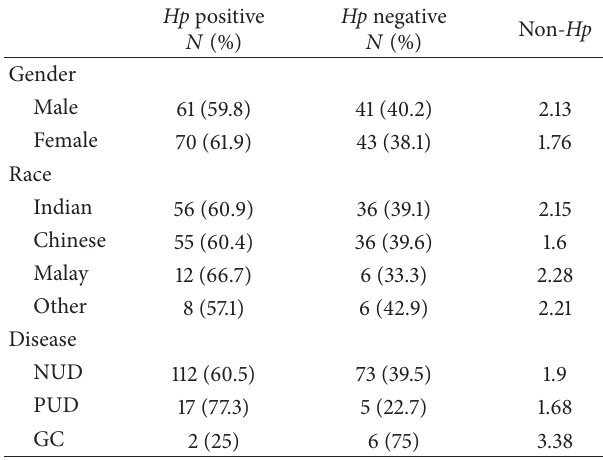
Table 1: Demographic data, prevalence of Helicobacter pylori , and mean number of other microbial species isolated from gastric disease